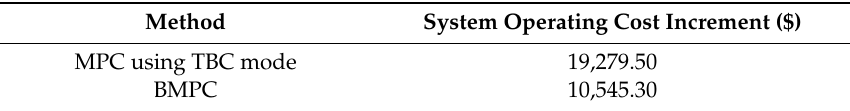
Table 6. Economic comparison of two control methods under output power of wind power random